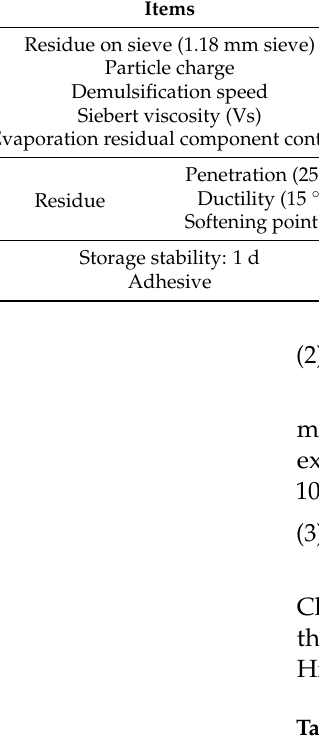
Table 2. Technical properties of mineral powder.